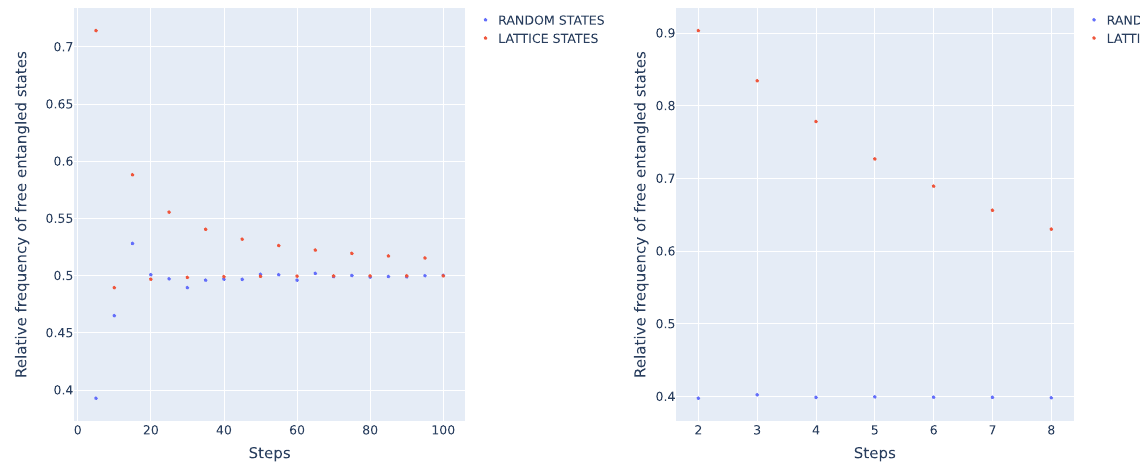
Figure 2. Relative frequency of free entangled states generated on a lattice (red) and by random sampling (blue) in dependence of the number of steps for M 2 for d = 2 (left) and E 3 for d = 3